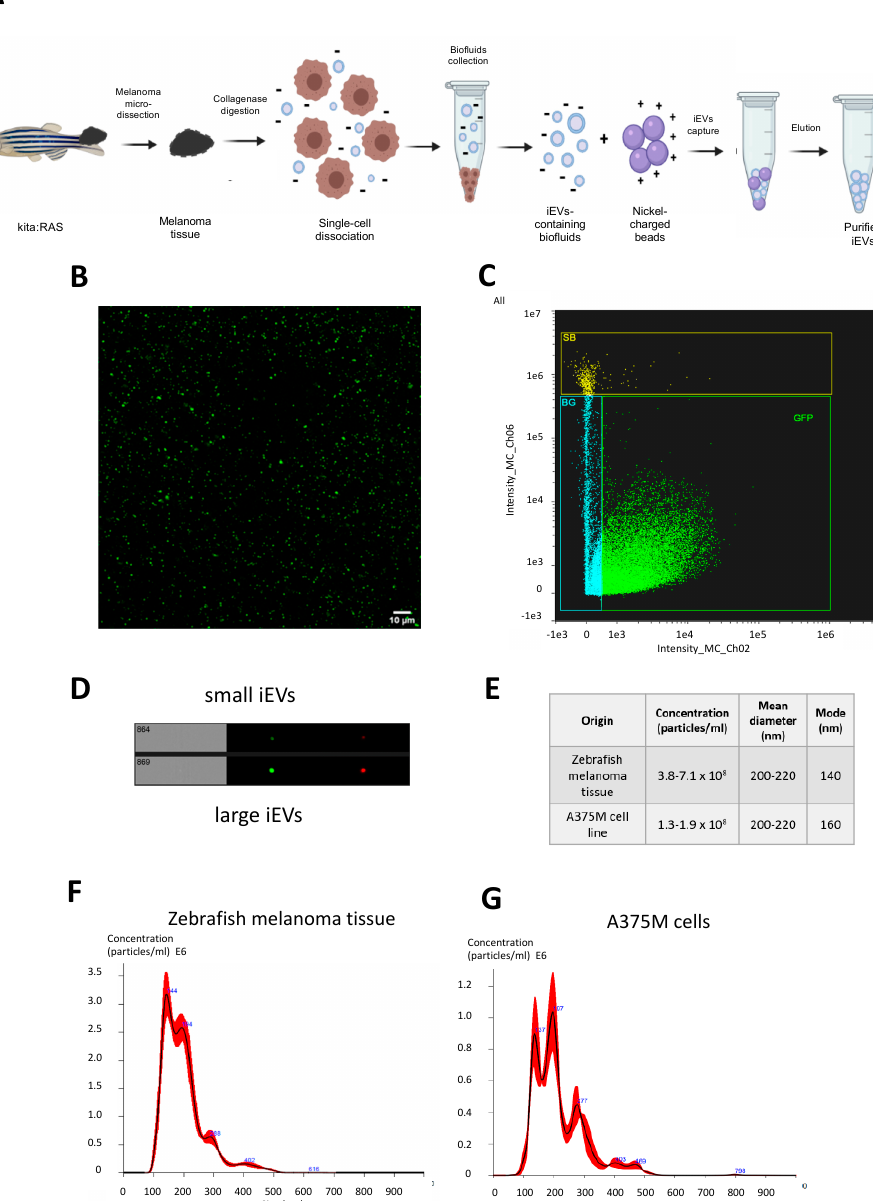
Figure 1. ( A ) Schematic representation of melanoma microdissection, single cells dissociation, and iEVs isolation following the NBI method. ( B ) Purified EVs from kita:RAS zebrafish melanomas (confocal microscopy, 63x magnification). ( C ) Representative sorting of iEVs isolated from kita:RAS zebrafish melanomas (ImageStream flow cytometer), and ( D ) single images of particles at the same instrument. ( E ) Table reporting concentration, mean, and mode diameter values retrieved from NTA performed on three independent biological samples from either kita:RAS zebrafish melanomas or the A375M human melanoma cell line. ( F ) Representative nanoparticle tracking analysis (NTA) profiles displaying concentration (particles/mL) vs. size distribution (nm) of iEVs isolated from kita:RAS zebrafish melanoma, and ( G ) EVs isolated from the cell culture supernatant of the A375M human melanoma cell line. The black curve indicates the mean of three measurements, with SD in red. Thus, transmission EM and WB analysis for exosome markers confirmed that zebrafish melanoma iEVs present morphological and biochemical features of extracellular vesicles, including